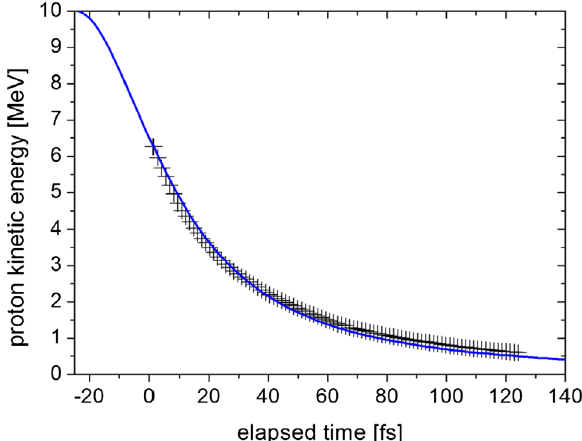
FIG. 7. Proton kinetic energy (crosses, experimental data) at the observed density maximum plotted at a temporal position concerning the maximum number i and a following elapsed time i τ = 2 ∼ i × 1 . 35 fs. The blue line represents a model (cf. the text) p for how the proton energy decreases as a function of the hot- electron